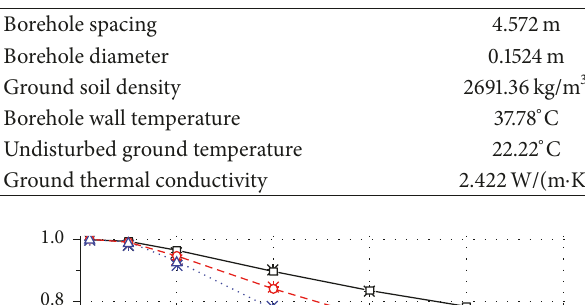
Table 2: Experimental data